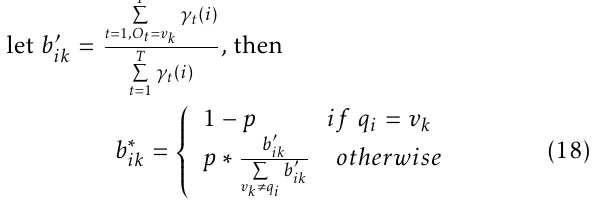
Table 1. k Nearest Distance Based Simulation Result ( p Indicates Prior Error Probability), OD denotes Outlier Detection, FA denotes False Alarm and EP denotes Error Probability.)